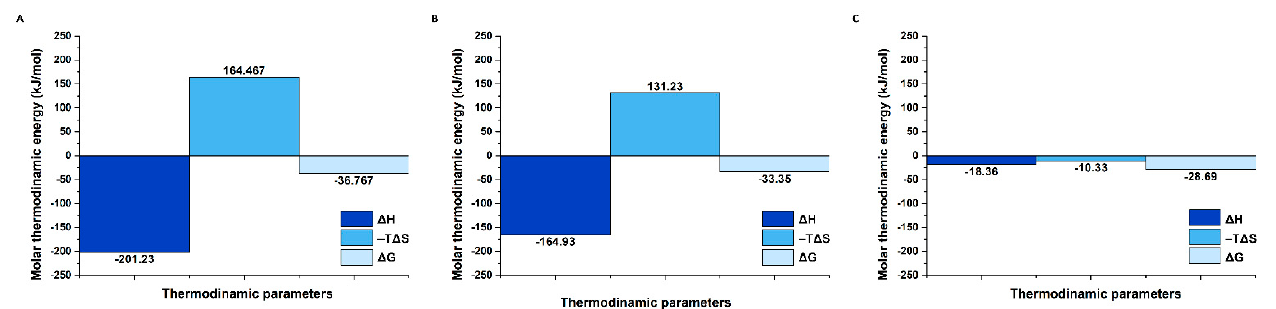
Figure 8. Thermodynamic data for the interaction between ( A ) A1 and miR21, ( B ) A2 and miR21, ( C ) A1 and